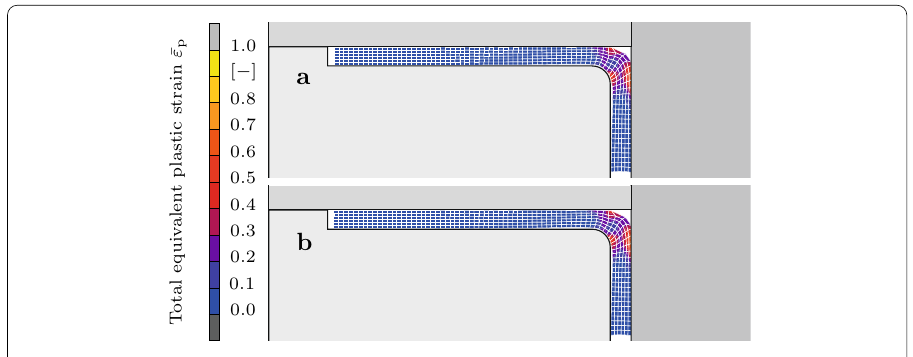
Fig. 17 Spatial (deformed) configurations according to the optimized material configurations with constraint of the available design space. Figure 13a → ( a ), Fig. 13b → ( b )